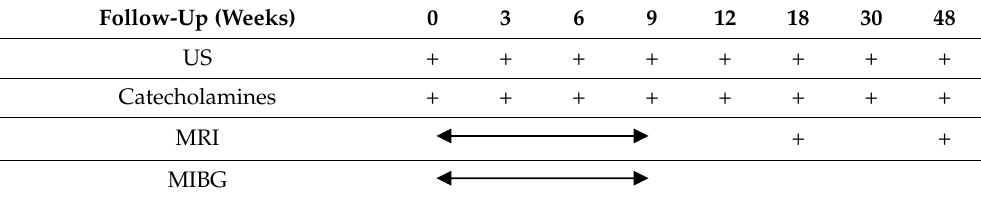
Table 1. Observation: Procedures.